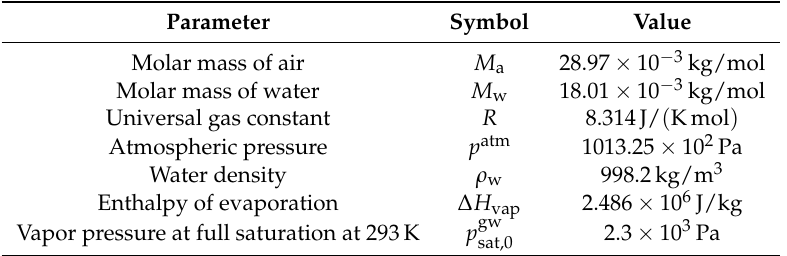
Table 2. Parameters for the Kelvin-Laplace, Clausius Clapeyron, and ideal gas